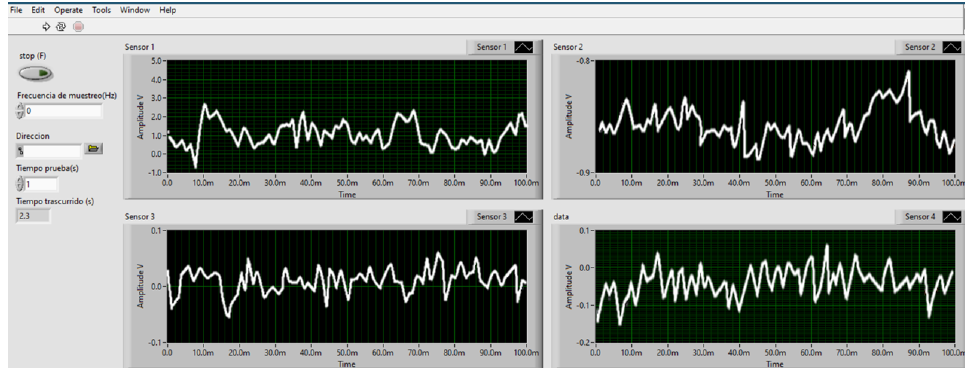
Figure 3. Window with the 4 graphs for each channel in the user interface.